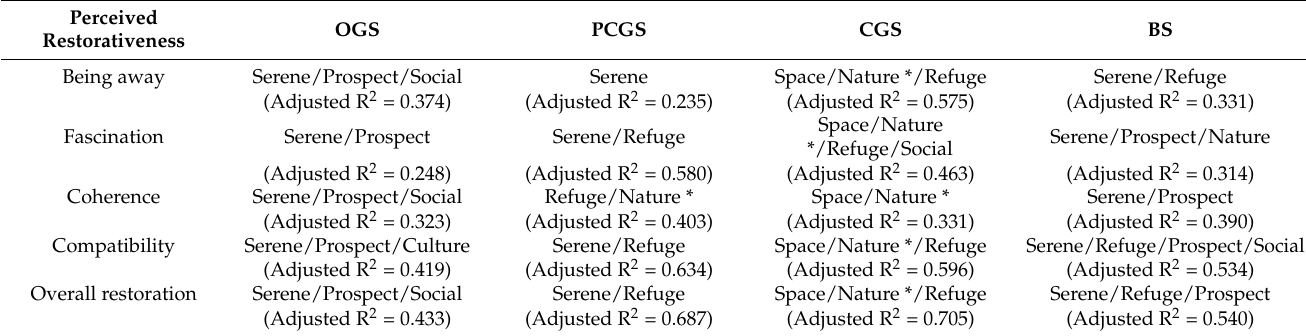
Table 5. The PSDs that had significant effects on psychological